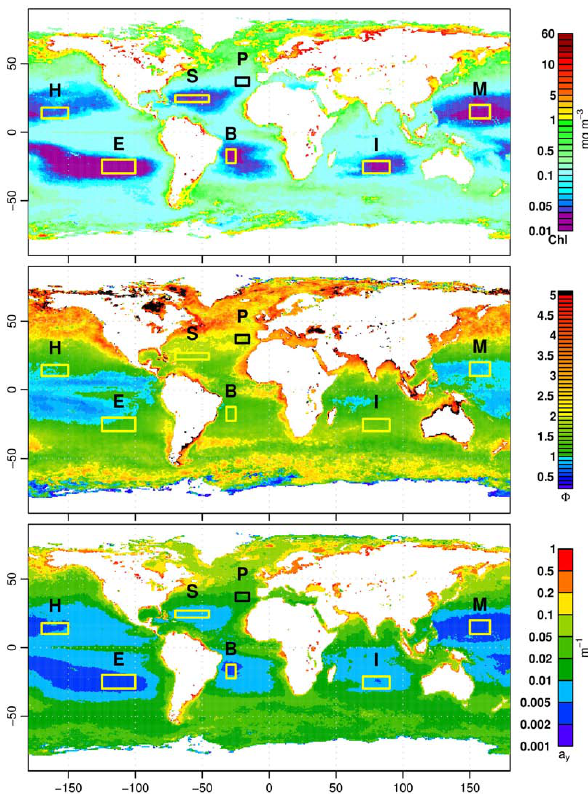
Fig. 1. Annual composite (year 2006) of SeaWiFS data for the global ocean. Upper panel: chlorophyll concentration, [Chl] (mgm − 3 ) ; middle panel: chromophoric dissolved matter index, 8 (dimensionless). Both these quantities are provided and dis- tributed by NASA. Lower panel: map of the absorption coefficient at 443nm, a y (m − 1 ) of the chromophoric dissolved organic matter, CDOM, computed from [Chl] and 8 via Eq. (1). Each panel has its own color scale. The (yellow) boxes superimposed on the maps show the oligotrophic zones selected for the present study (see also Table 1 for the exact locations and meaning of the identifiers). The black box in a mesotrophic zone off Portugal (P) is selected for a comparison (see